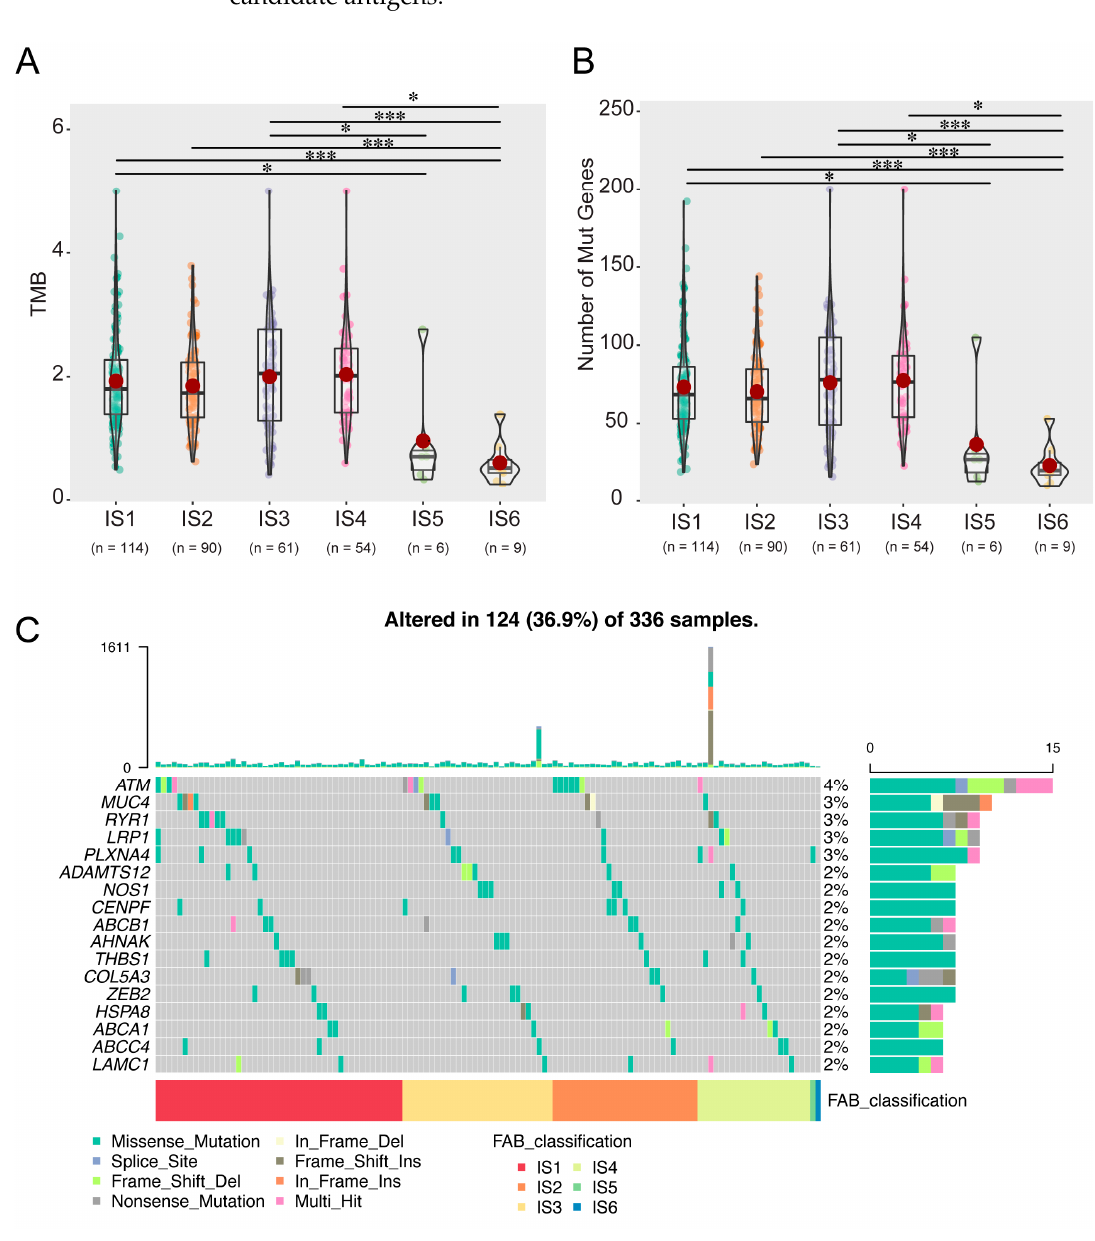
Figure 6. Correlation of immune subtypes with TMB and mutation. The TMB ( A ) and mutation numbers ( B ) in IS1–6 tumours. ( C ) Proportion of 17 highly mutated genes in KIRC immune sub- types. (* p < 0.05, *** p < 0.001). Tumor mutation burden (TMB); Immune subtype (IS); Kidney renal clear cell carcinoma (KIRC).